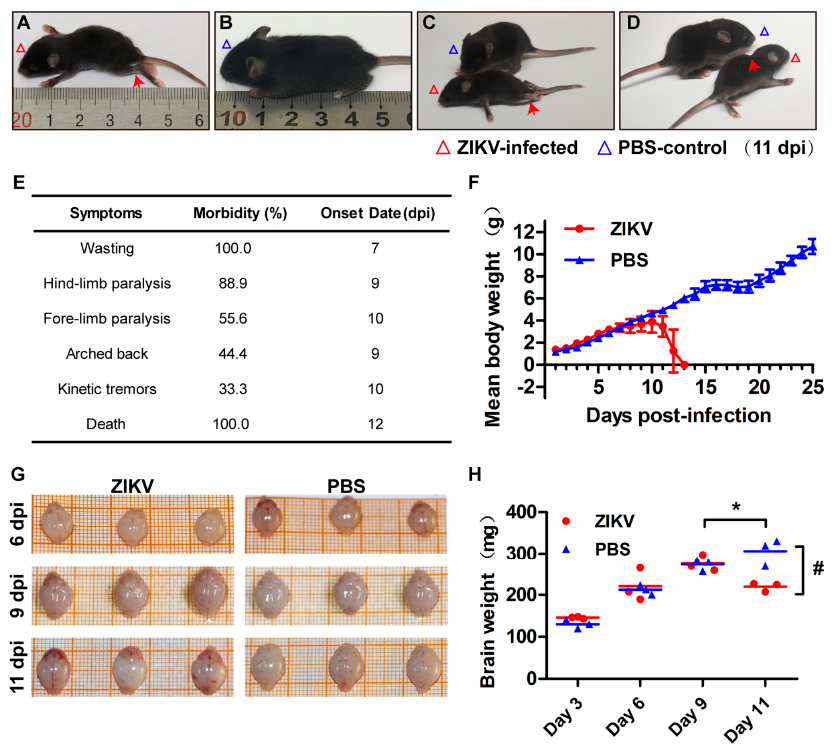
Figure 7. Pathogenic manifestations of PRVABC59 infection in the 1-day-old C57BL/6 mice. The PRVABC59-infected 1-day-old mice were closely observed and typical symptoms were recorded. Representative images at 11 dpi presented as: ( A ) Hind-limb paralysis a; ( B ) PBS-injected mouse control; ( C ) (upper versus lower). PBS-injected control mouse versus wasting and paralysis; ( D ) form an arch on back; ( E ) Symptoms, morbidity rate, and onset date of PRVABC59-infected mice; ( F ) The averaged body weight of ZIKV-infected or PBS-injected Mice ( n = 8–10 per group); ( G ) Whole brain sizes; ( H ) Brain weights. The averaged brain weight from ZIKV-infected or PBS-injected mice at 3, 6, 9, or 11 dpi ( n = 3). * p < 0.05, the averaged brain weight from ZIKV-infected mice at 9 dpi was compared to that at 11 dpi. # p < 0.05, the averaged brain weight from ZIKV-infected mice was compared with that of PBS-injected mice at 11 dpi, all data are means ± S.D., t -test.